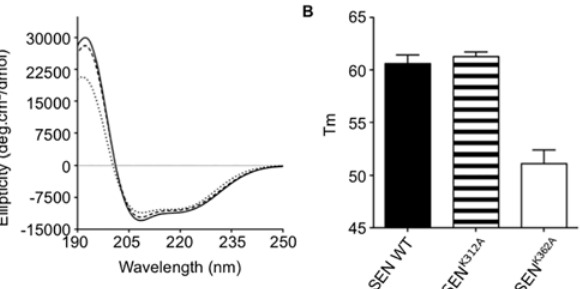
Fig 5. Biophysical characterization of wild-type and mutant SEN. ( A ) Far-UV circular dichroism spectra demonstrating the predominantly α -helical secondary structure of recombinant wild-type SEN (solid), SEN K312A (dashed) and SEN K362A (dotted). ( B ) Comparison of the thermal stability of wild-type SEN (black), SEN K312A (striped) and SEN K362A (clear) determined by the thermofluor assay. The assay was performed in triplicate and error bars indicate the standard